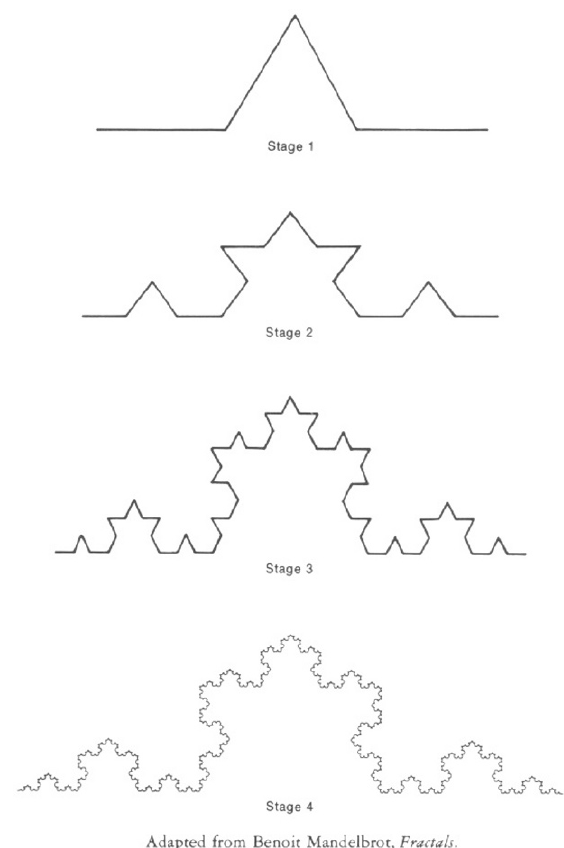
Figure 1. Koch curve fractal and its 4 iterations.